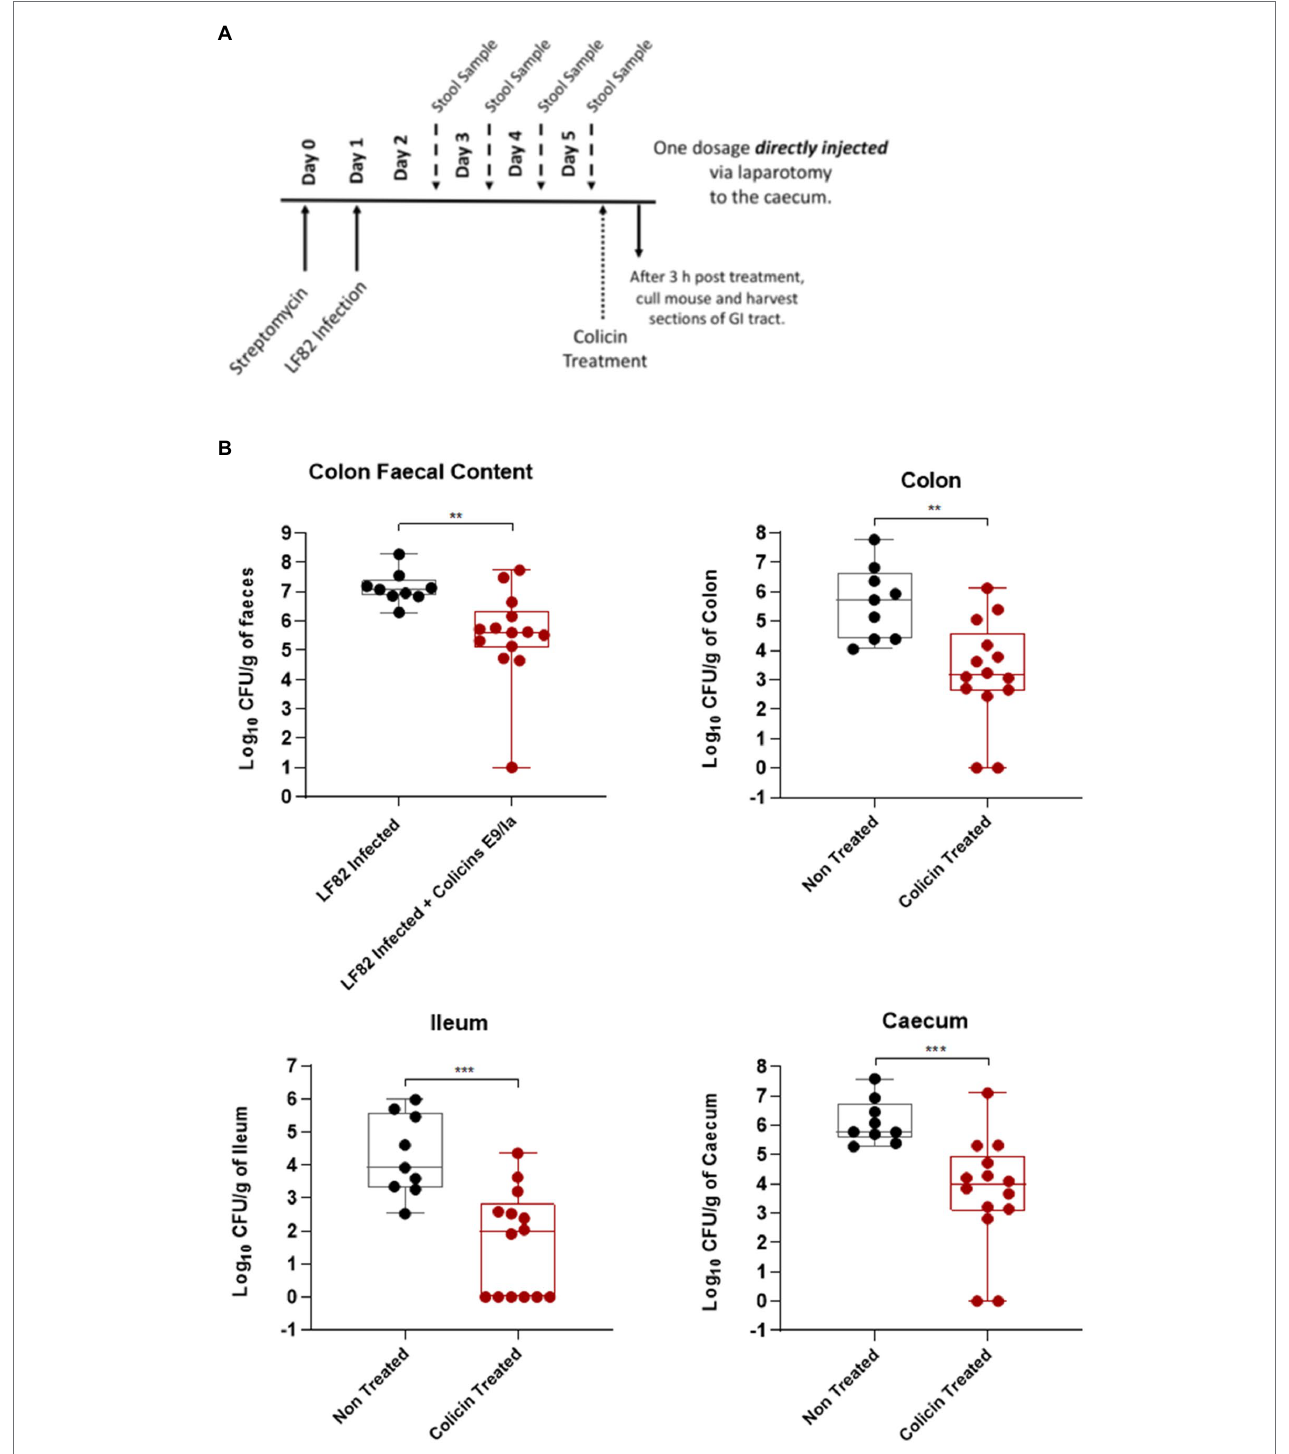
FIGURE 2 | Direct administration of a colicin cocktail reduces levels of LF82 colonization of infected mice. An Escherichia coli LF82StrpR murine infection model was used to assess the efficacy of a colicin cocktail treatment directly administered to the caecum via laparotomy. Four days after LF82StrpR challenge, mice were treated with the administration via laparotomy of 50 μ l of a combination of E9 and Ia (0.5 mg ml − 1 each) or 50 μ l of PBS (control group). (A) Experimental scheme. (B) Levels of LF82StrpR strain in both control (black, n = 10) and colicin treated (red, n = 14) groups for the different sections of the GI tract. Statistical analysis was carried out for each subset using a Mann–Whitney test between LF82StrpR infected and colicin-treated groups. ** p < 0.002, *** p <